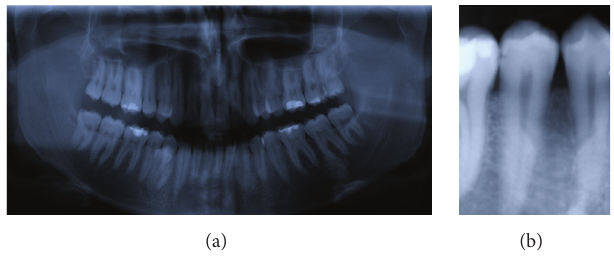
Figure 4: Case 3 radiography: ST in 4.4–4.5 region 2015 (a) and after extraction 2015 (b).